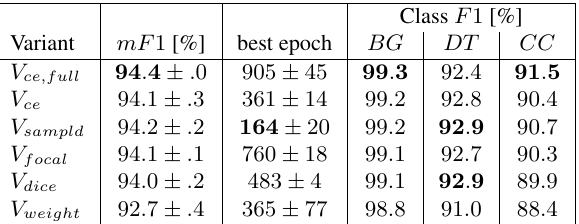
Table 4. Performance of different variants of the classification model on the test set. V sampld refers to the proposed variant. Best epochs and mF 1 scores are reported as means and standard deviations over three runs. For the class-wise metrics the means are given. The best results per column are printed in bold font.